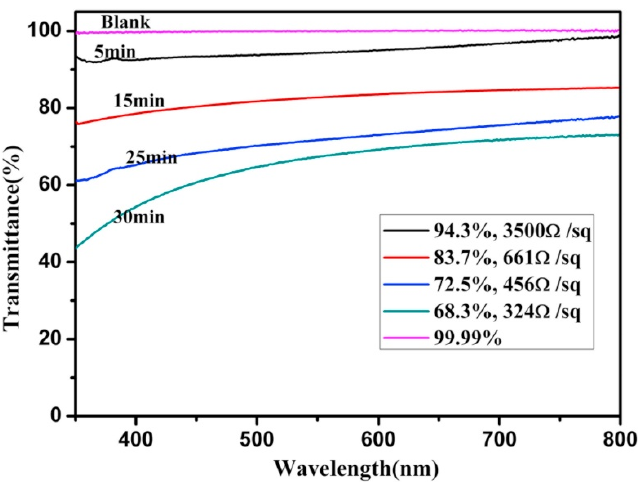
Figure 10. UV–VIS spectra of graphene films grown on glass with varying growth time (5, 15, 25, and 30 min) and the corresponding sheet resistance [50].